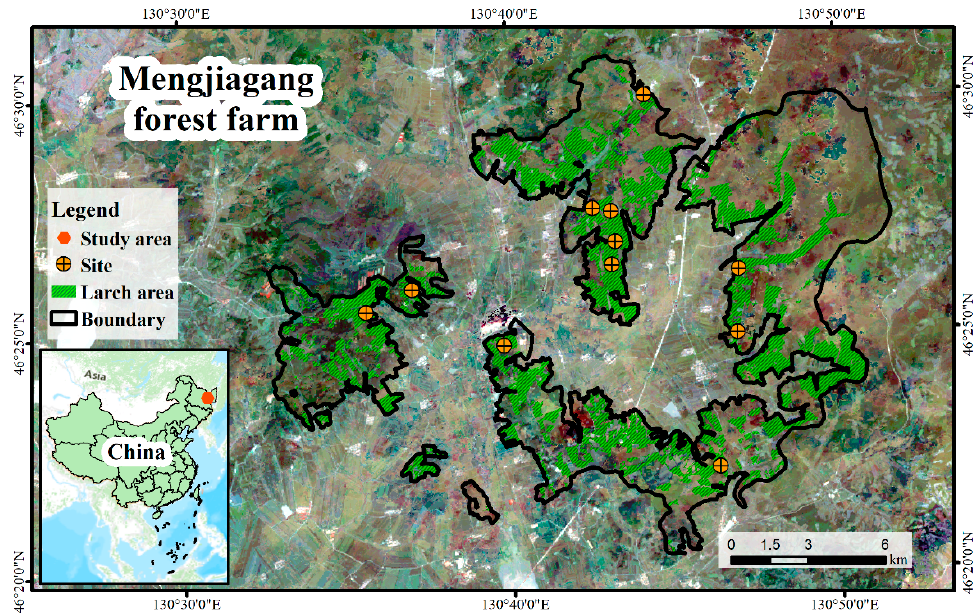
Figure 1. The site locations in the study area (coordinate system: WGS 1984 UTM Zone 52N). UAVLS data were acquired for these 11 sites from 10 to 12 July 2019, using a RIEGL mini VUX-1UAV LiDAR scanner (www.riegl.com/products/unmanned-scanning/riegl- minivux-1uav) carried by a Feima D200 UAV platform. The LiDAR sensor operated at a 100 kHz pulse repetition rate with a maximum scan speed of 100 scans per second. The scanner’s maximum measurement range was 250 m with an accuracy of 15 mm. All the